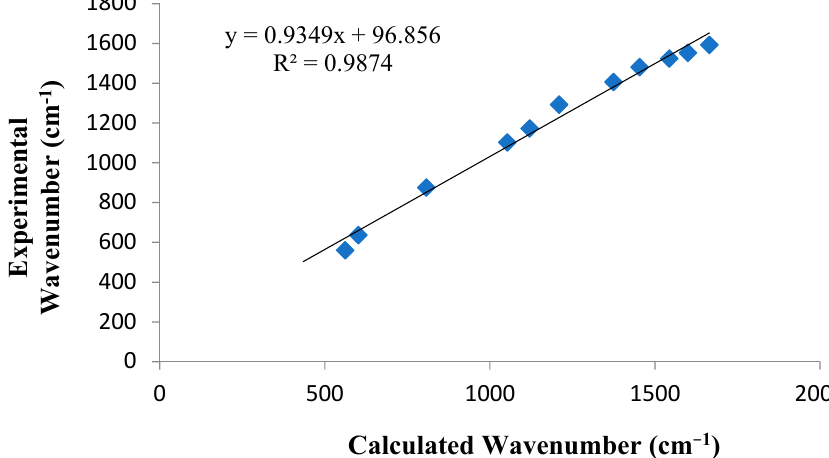
Figure 11. Calculated vs. experimental wavenumbers of (C 6 H 8 Cl 2 N 2 ) 2 [Cd 3 Cl 10 ] · 6H 2 O.